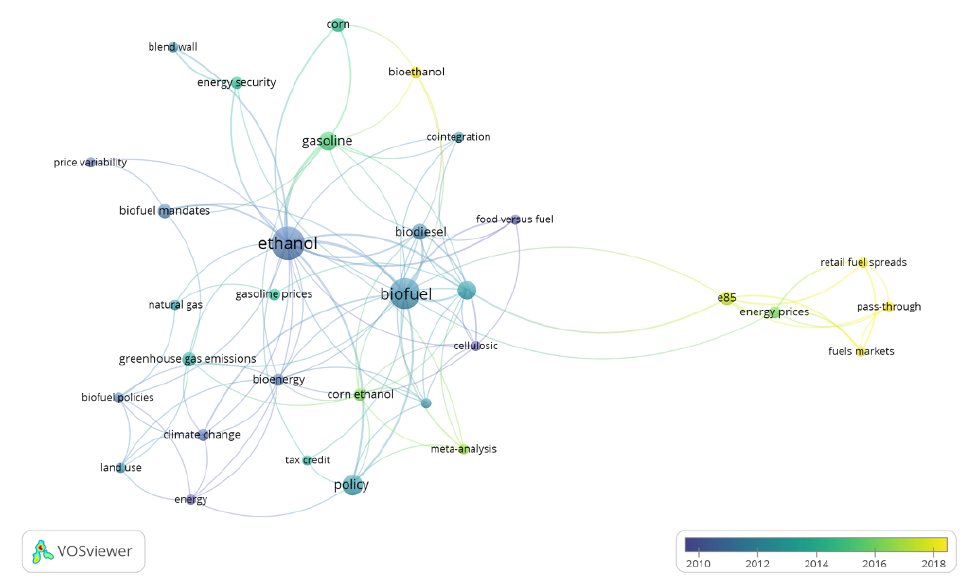
Figure 11. Keyword co-occurrence